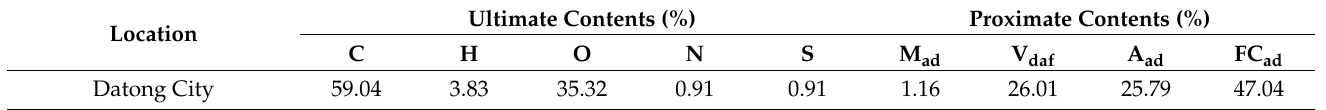
Table 1. Ultimate and proximate contents of the coal dust.